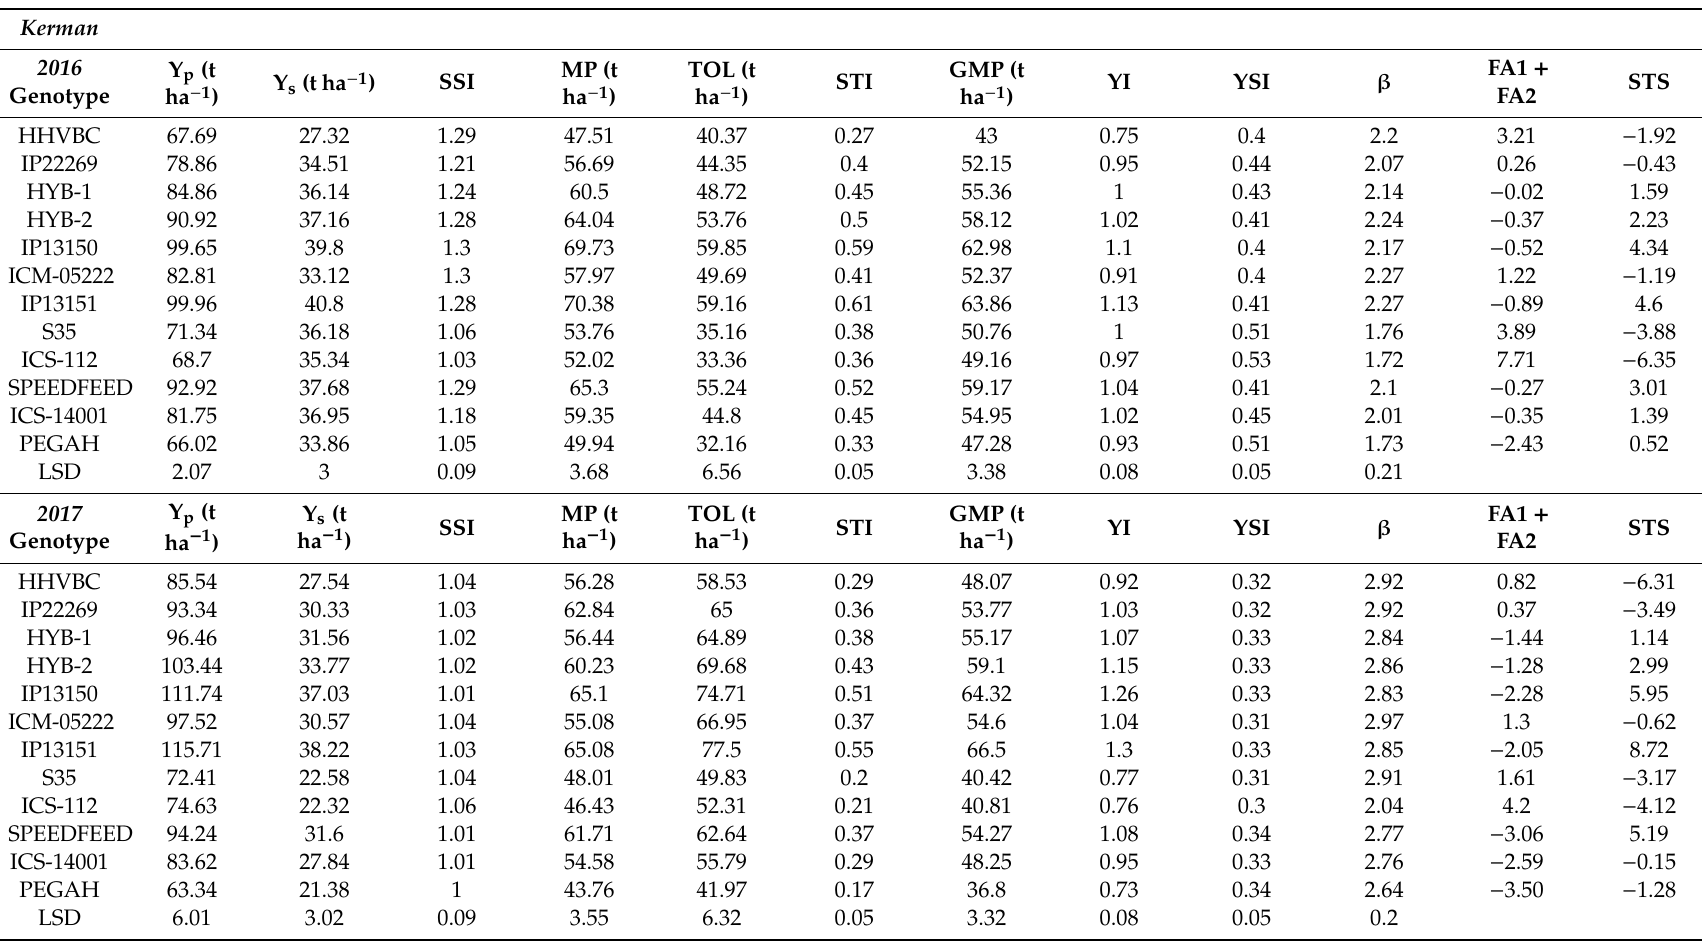
Table 8. Mean yield in regularly irrigated (Y p ) and water deficiency (Y s ) conditions and drought tolerance / susceptibility indices for genotypes in three years.